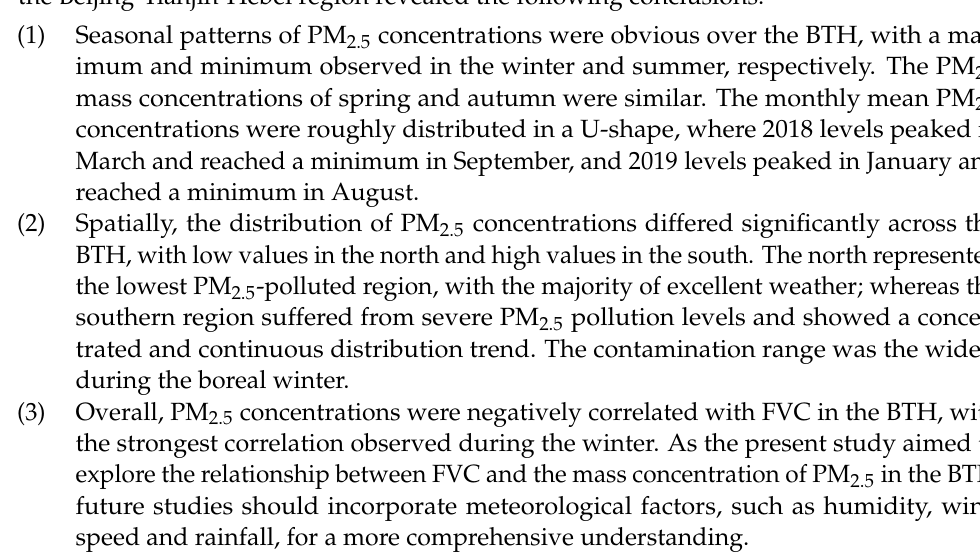
Table 1. Seasonal and annual Spearman correlation coefficient values between PM 2.5 and fractional vegetation cover over the Beijing-Tianjin-Hebei region (2018–2019). Time Interval Correlation Coefficient Spring − 0.269 ** Summer − 0.287 ** Autumn − 0.347 ** Winter − 0.358 ** Annual − 0.346 ** ** passed the confidence test at α = 0.01, n =